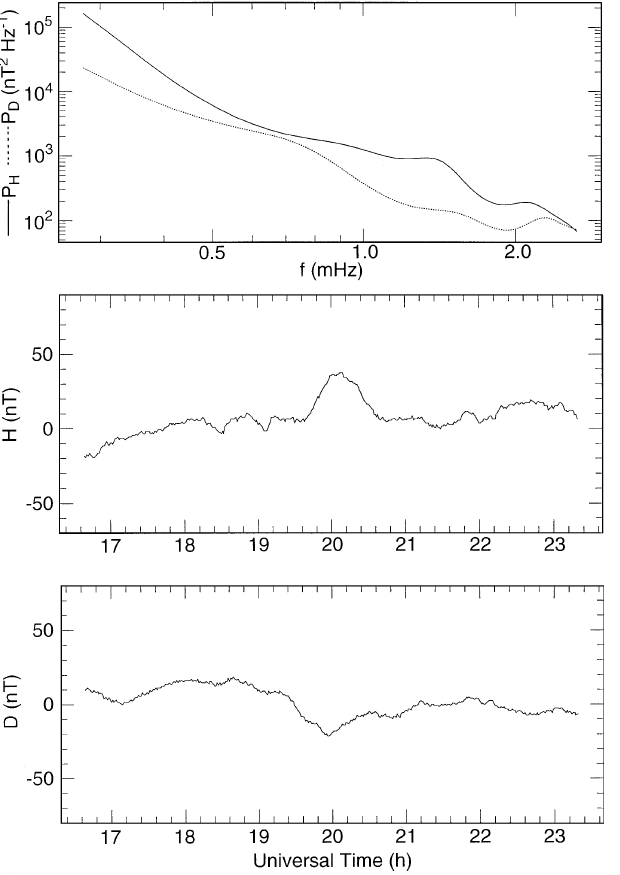
Fig. 4. Power spectra and time-series for 7 June 1985 event (20 — 23 LT)